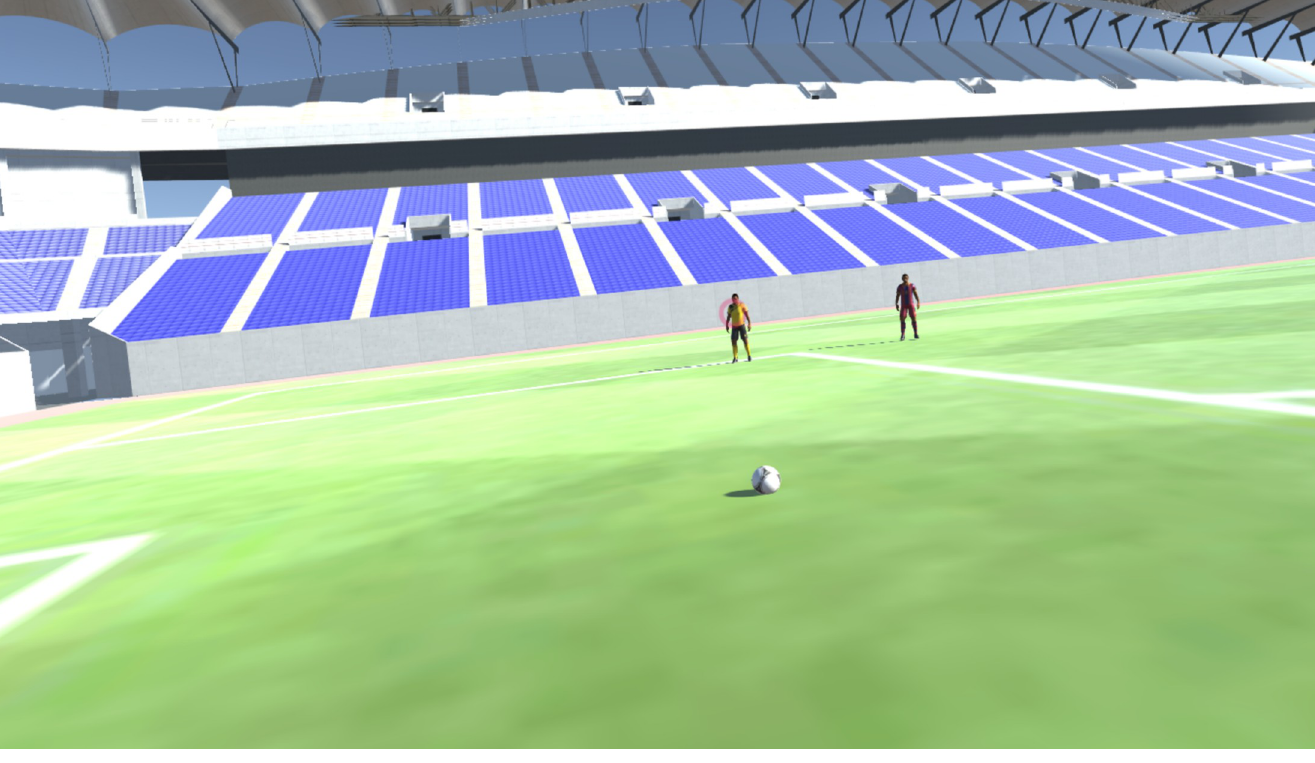
Fig 9. “Pass the ball”